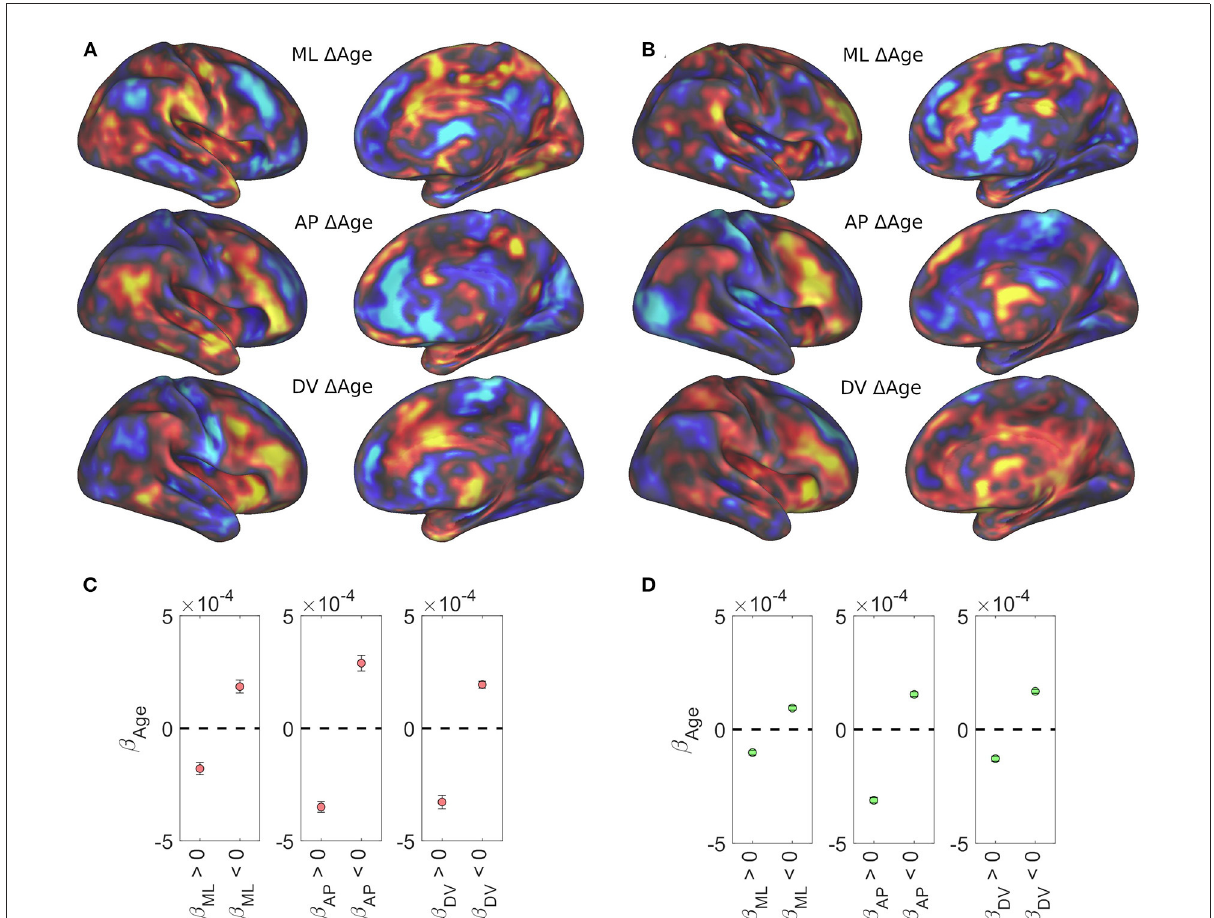
FIGURE4 Age-related regression results. All three caudate functional gradients showed reversed association with age. Age-related regression results for the Rockland sample (A) and the Rockland Enhanced sample (B) are shown unthresholded across the brain. Average beta weight for age across significantly positive and significantly negative spatial weights in the Rockland sample (C) and the Rockland Enhanced sample (D)